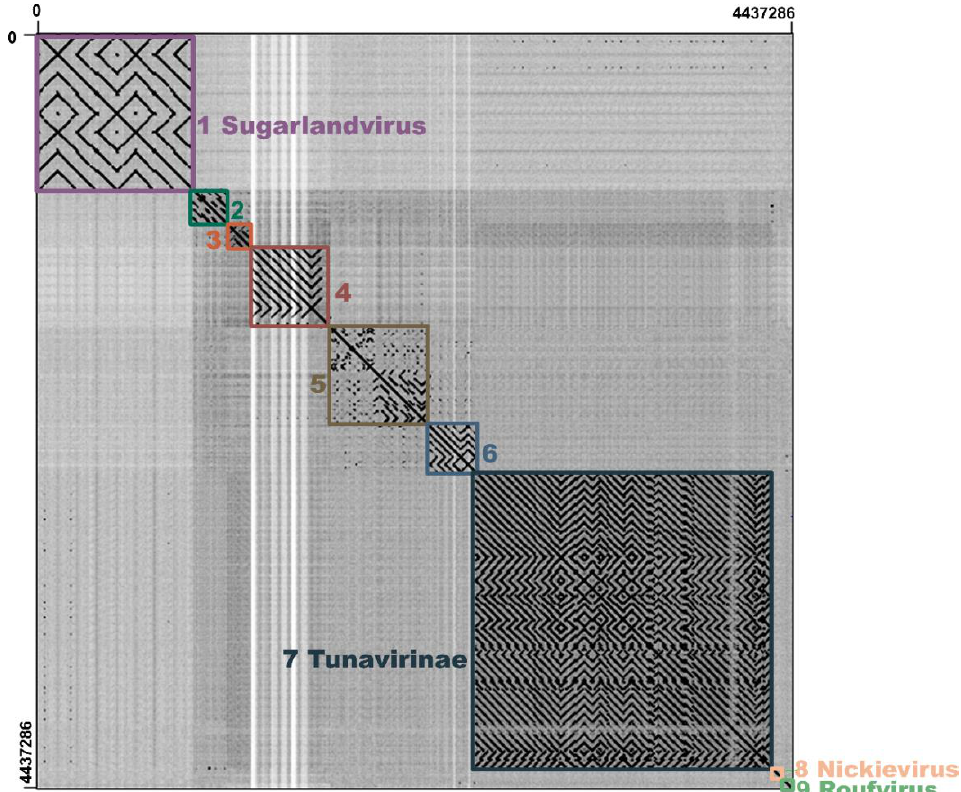
Figure 6. Dot plotting analysis of the genomes of the Siphoviridae family phages infecting Klebsiella. The phage genomes were used as the list in Table S4. The dot plotting analysis was performed by using Gepard.